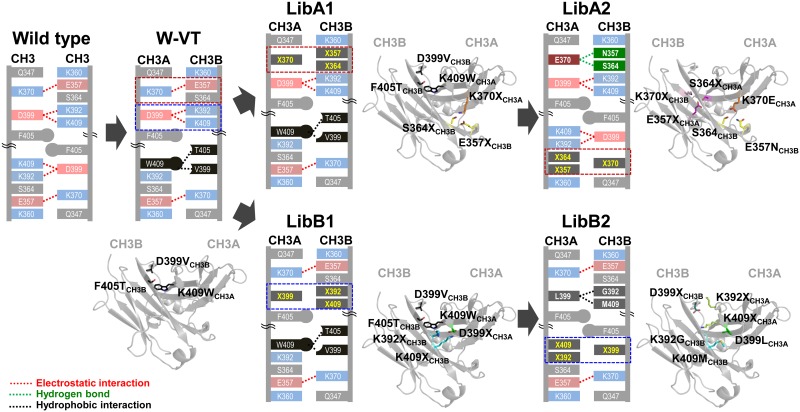
Schematic diagrams showing the overall strategy and sequential process of constructing the combinatorial heterodimeric Fc library.The cartoons depict major interactions contributing to the homodimeric CH3 interactions of wild type Fc and the heterodimeric CH3A-CH3B interactions in the heterodimeric Fc variants. The first libraries (LibA1 and LibB1) were constructed based on the W-VT variant (with K409WCH3A-D399V/F405TCH3B) by randomizing the homodimer-favoring K370CH3A-E357/S364CH3B and D399CH3A-K392/K409CH3B paired residues, respectively, which are located in the opposite side of the W-VT variant pair. Screening of the LibA1 and LibB1 libraries generated the variants with the highest heterodimerization yield, A107w/o W-VT (K370ECH3A-E357NCH3B) and B168w/o W-VT (D399LCH3A-K392G/K409MCH3B), respectively. In the LibA2 and LibB2 libraries, the other homodimer-favoring residues E357/S364CH3A-K370CH3B and K392/K409CH3A-D399CH3B, which are located on the opposite site of the mutated residues in LibA1 and LibB1, were randomized based on the A107w/o W-VT and B168w/o W-VT templates, respectively. The CH3 domain interfaces were modeled using the 2.5 Å crystal structure of the EW-RVT variant (PDB code 4X98; [18]). The mutant residues in each library are depicted as sticks and indicated as X. The images were illustrated using PyMOL (Schrödinger, Inc.).